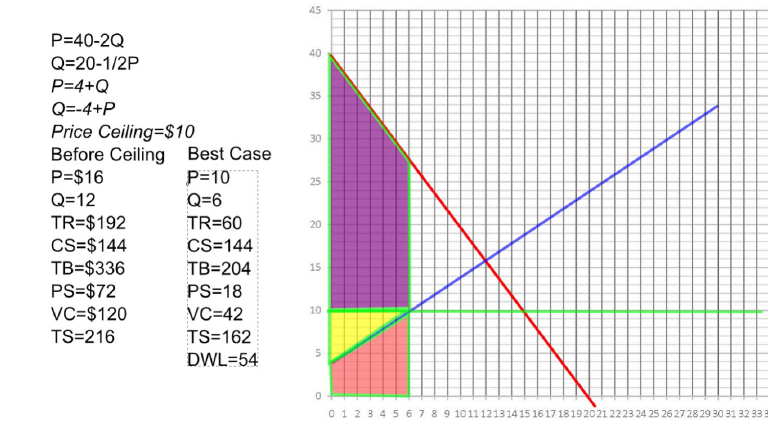
Figure 2: Using InkScape to Perform Welfare Analysis of Price Ceiling